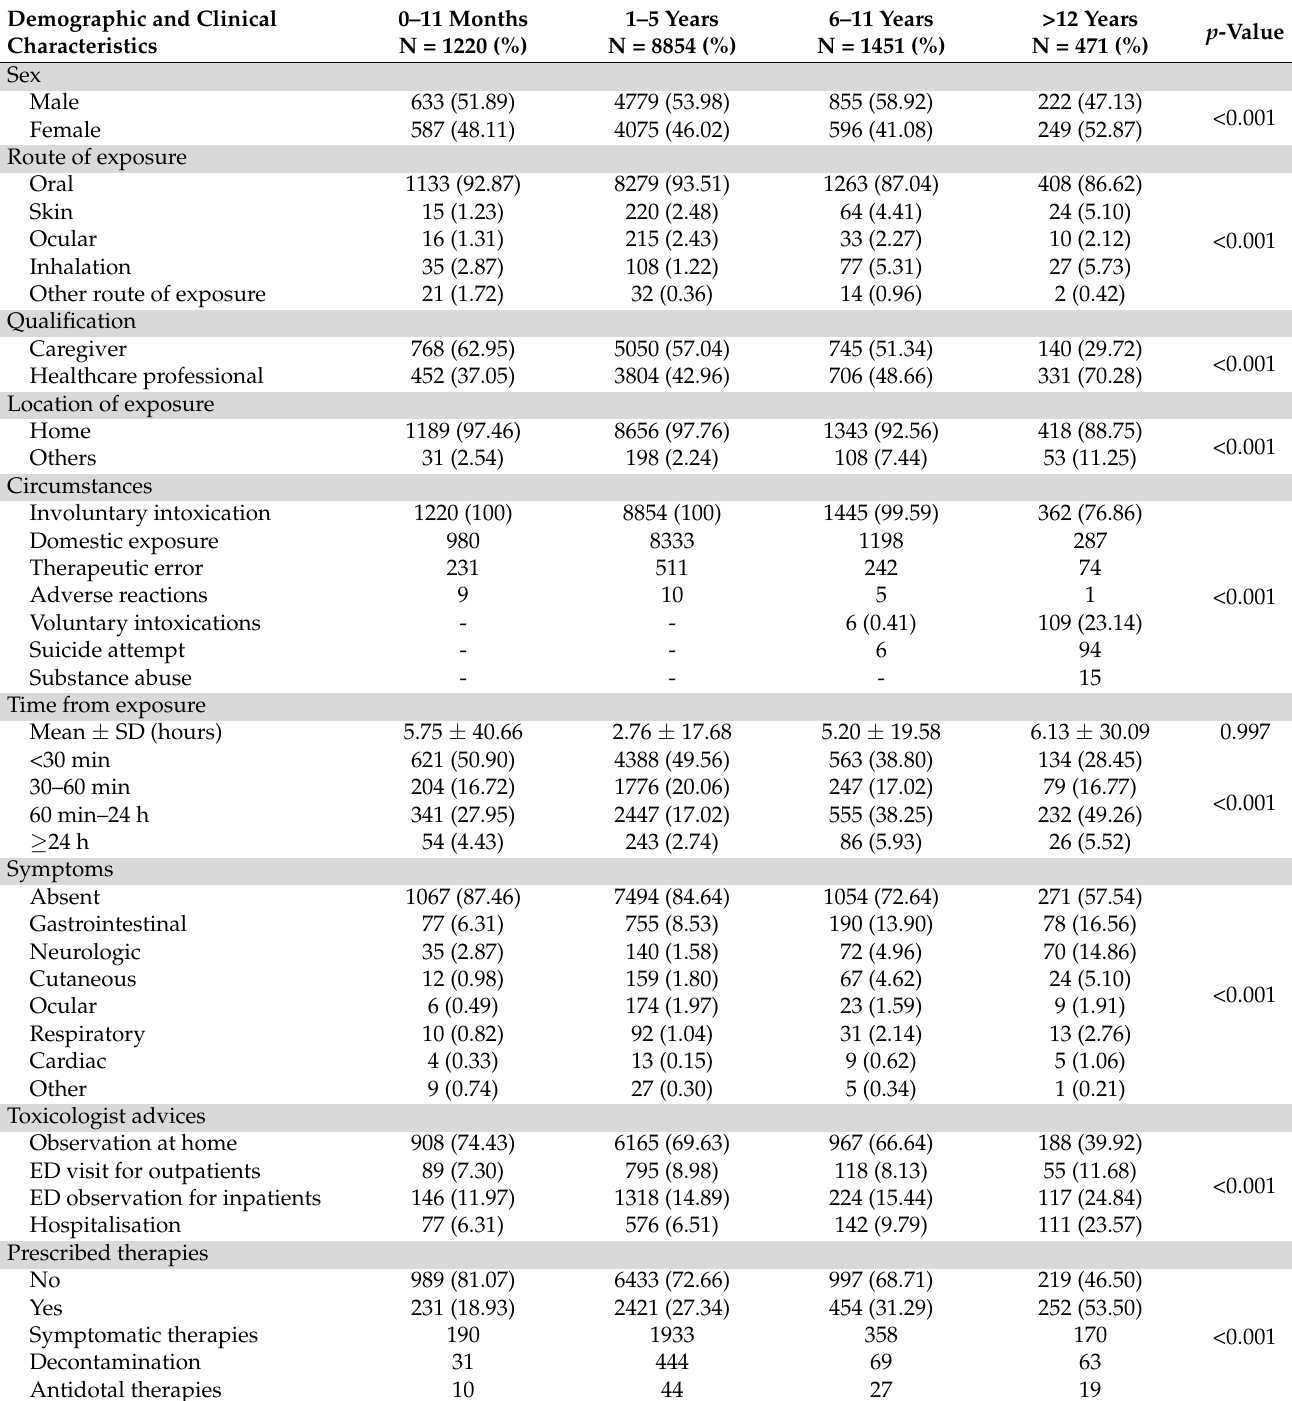
Table 1. Demographic and clinical characteristics (N =